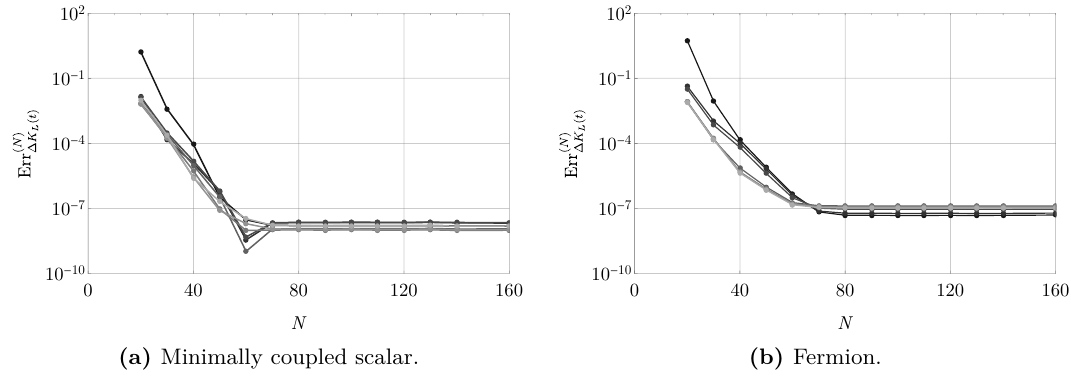
Figure 14. The fractional error (C.13) in the differenced heat kernel on the geometry given by the embedding (4.9) with ‘ = 3 and (cid:15)/(cid:15) max = 0 . 5 ; from dark to light gray, the curves correspond to t = 0 . 05 , 0 . 1 , 0 . 2 , 1 , 2 , 4 , 8